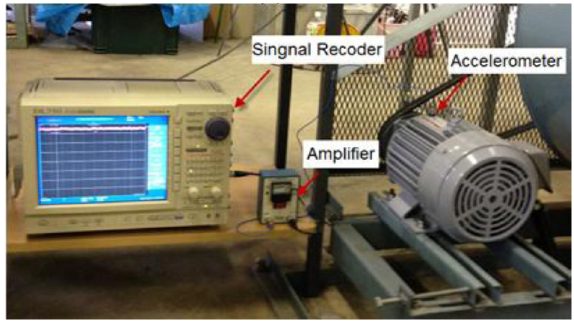
Figure 10. Experimental setup for the rolling bearing fault diagnosis.